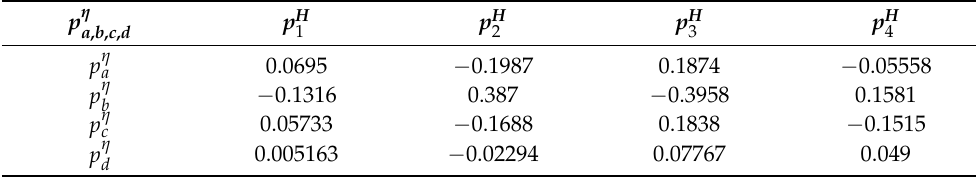
Table A3. Coefficients of the fitting model for Galileo system (Mean orbital height: 23,220 km). 𝒑 𝒂,𝒃,𝒄,𝒅𝜼 𝒑 𝟏𝑯 𝒑 𝟐𝑯 𝒑 𝟑𝑯 𝒑 𝟒𝑯 𝑝 𝑎𝜂 0.05364 𝜂 𝑝 𝑏